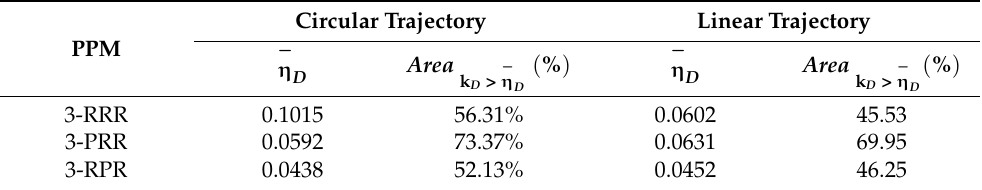
Table 4. Comparison of the global dynamic dexterity of three PPMs. Circular PPM